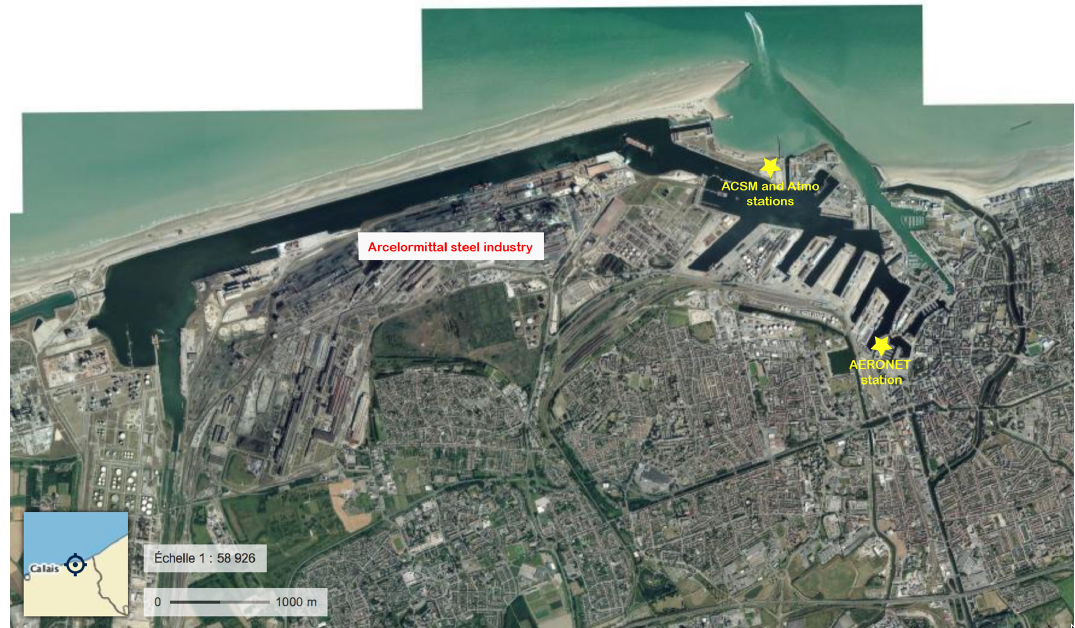
Figure A1. Location in Dunkirk of the ACSM and Atmo stations at Port-East as well as the AERONET station. The aerial image used as a base map is from the Geoportail of the French government (https://www.geoportail.gouv.fr, last access: 14 November 2019). Note that the Arcelormittal site is the only one mentioned on the map as it represents the largest source of particles from the steel industry in Dunkirk, well ahead of the other industrial activities, according to Clerc et al. (2012).